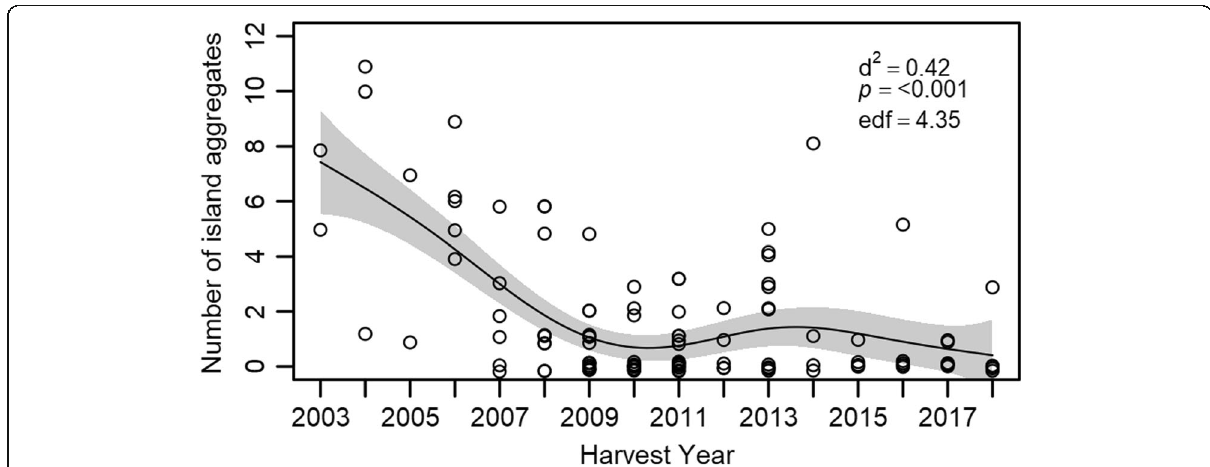
Fig. 5 Results of generalized additive model for evaluating the patterns in number of island aggregates in ARN coupes ( n =115). Shaded areas indicate the 95% confidence interval. Symbols are partial residuals around the predicted effects. d 2 is the proportion of the null deviance explained by the model. p values indicate the approximate significance of the single smooth term, while edf is the estimated degrees of freedom for the smooth